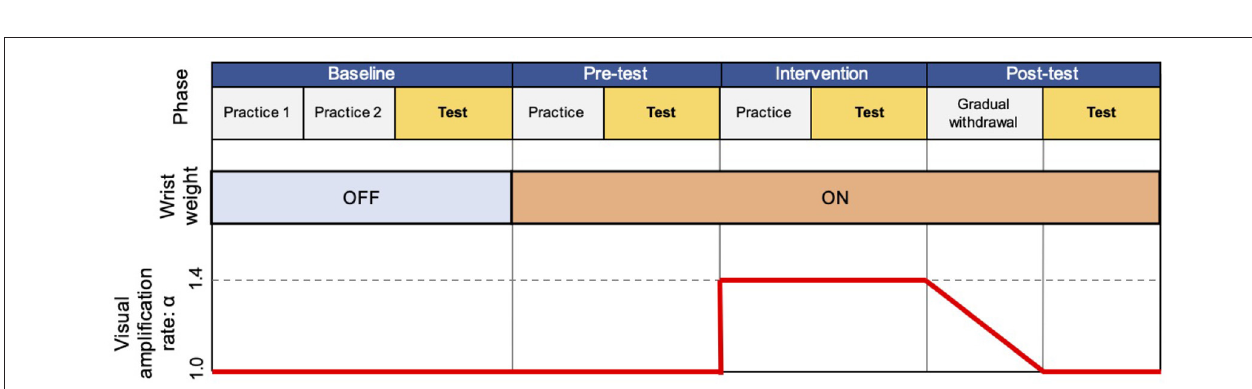
To test if the wrist weight leads to less usage of the dominant hand and visual enhancement causes recovery of the usage, the border angles during the four experimental phases were statistically evaluated using the Friedman test.